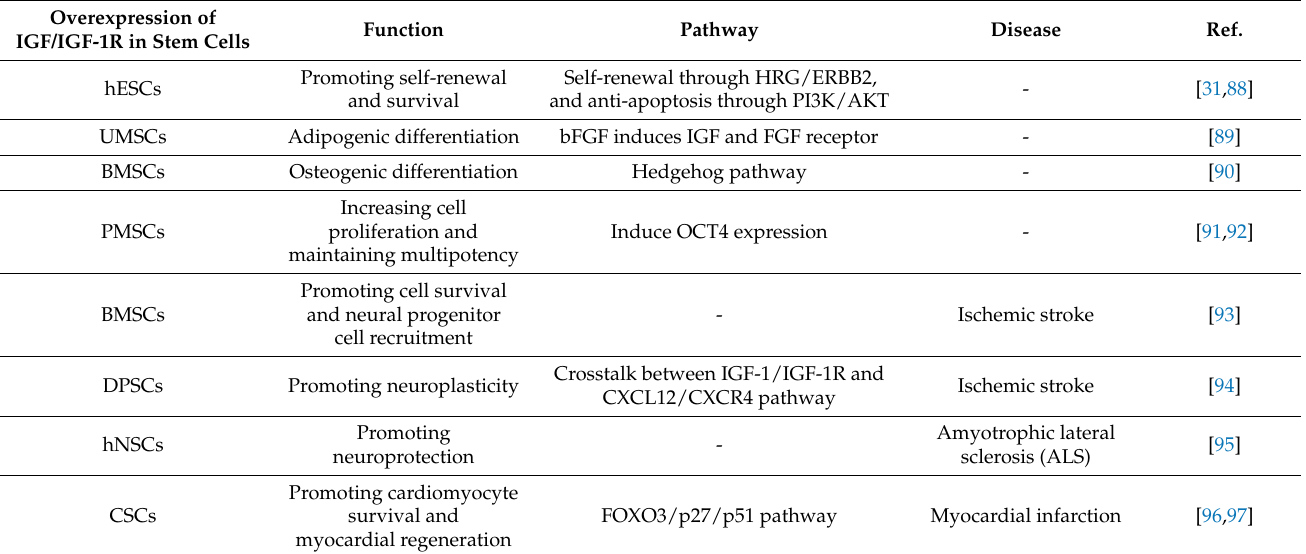
Table 1. Therapy efficacy in stem cells and MSCs that overexpress IGF-1R in regenerative medicine. Overexpression of IGF/IGF-1R in Stem